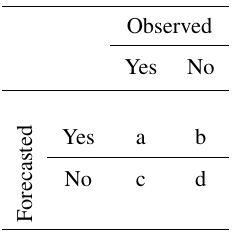
Table 2. Contingency table to support Eqs. (2) and